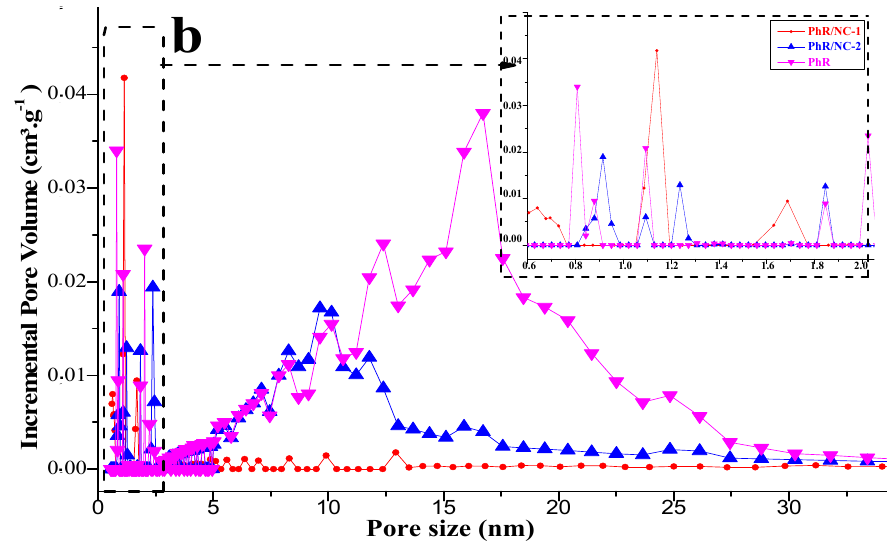
Figure 4. ( a ) Nitrogen adsorption/desorption isotherms of carbon materials; ( b ) Density Functional Theory (DFT) Pore size distribution.